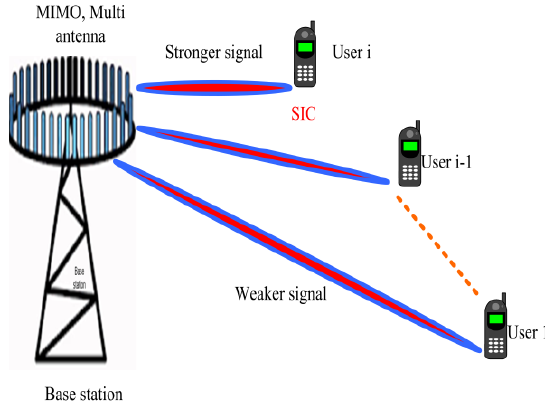
Figure 1. Traditional MIMO-NOMA system optimum power